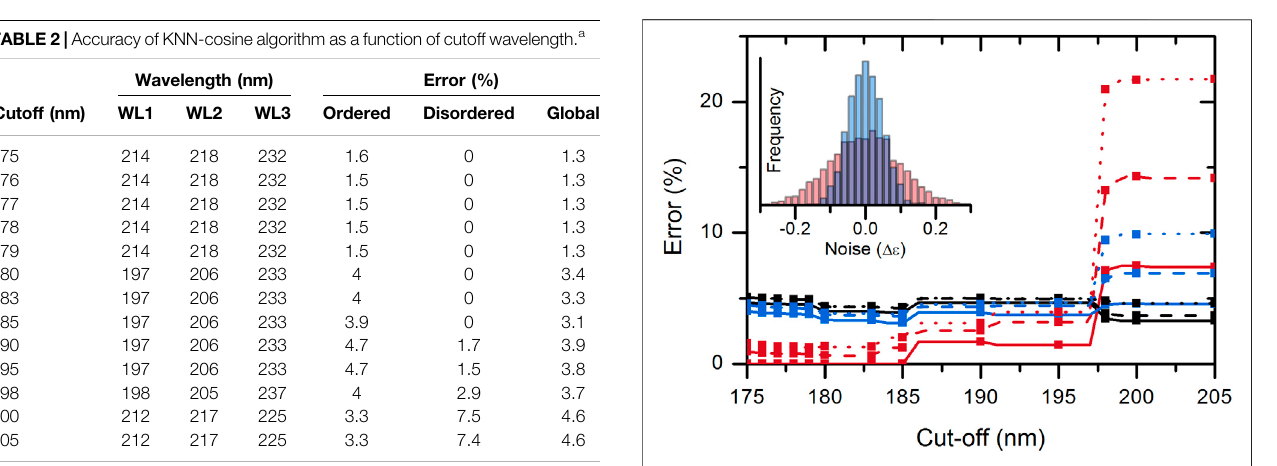
a Wavelengths of the data points (WL1, WL2, WL3) for the best performance at each cutoff and the errors of classi fi cation are shown.